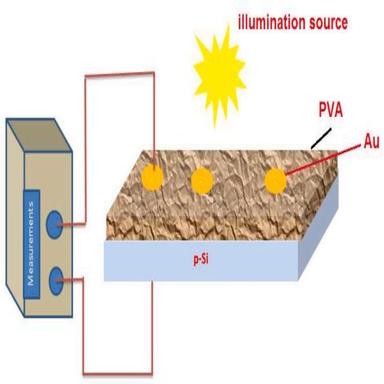
Schematic diagram of PVA/p-Si heterojunction for measurement.